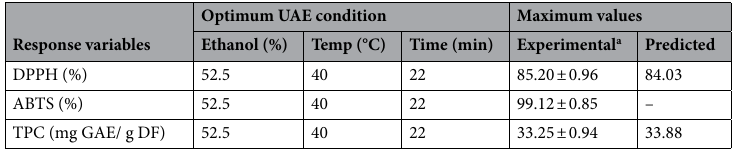
Table 5. Estimated optimum conditions for DPPH, ABTS and TPC. a Data are presented as mean ± SD from triplicate experiments.